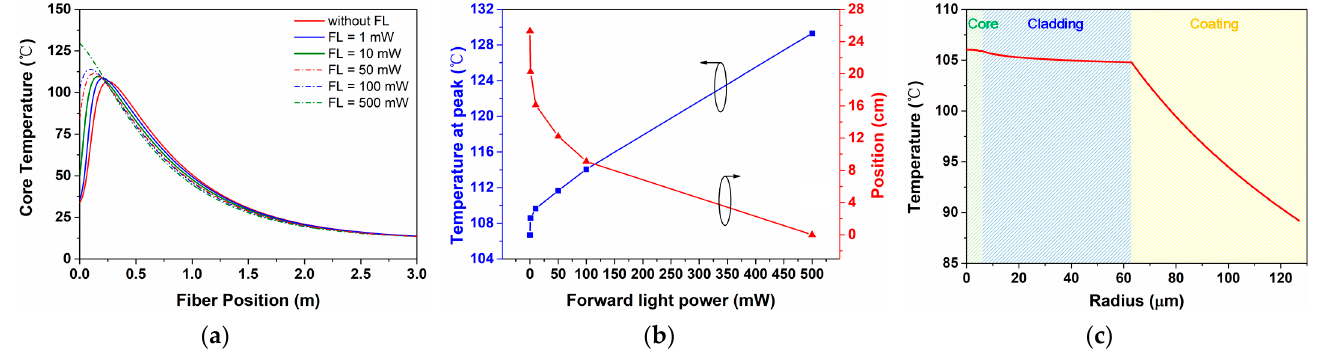
Figure 3. ( a ) The core temperature distributions of the gain fiber with different FL power. ( b ) Peak temperature and its location as a function of the FL power. ( c ) Fiber radial temperature distribution in the absence of the FL.